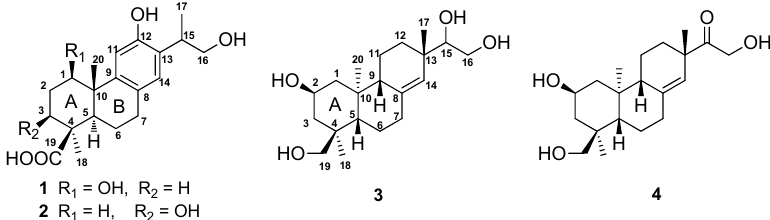
Figure 1. Chemical structures of compounds 1 ‒ 4 .